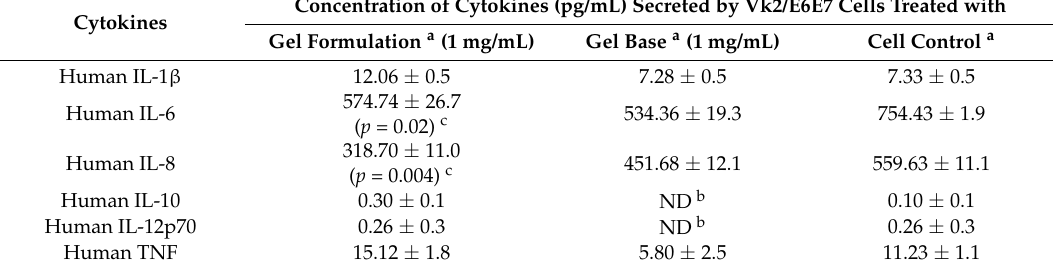
Table 3. Pro-inflammatory cytokines secretion by vaginal keratinocytes cells (Vk2/E6E7) after treatment with herbal gel formulation for 24 h.